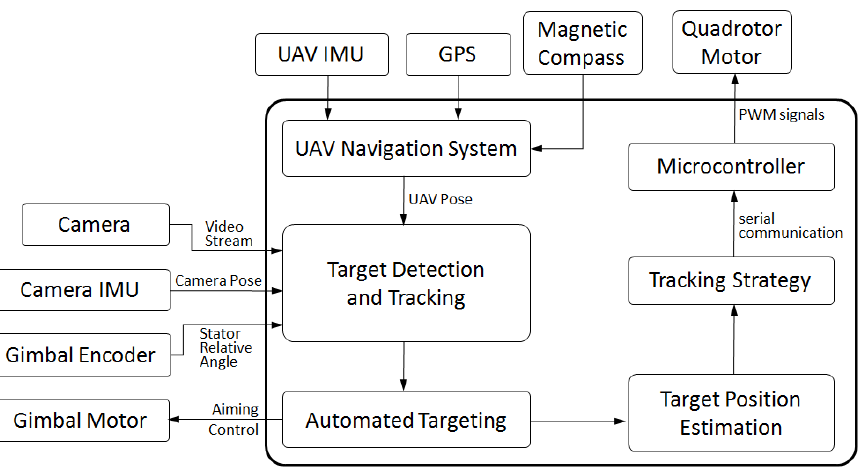
Figure 2. Architecture of the autonomous visual tracking system.